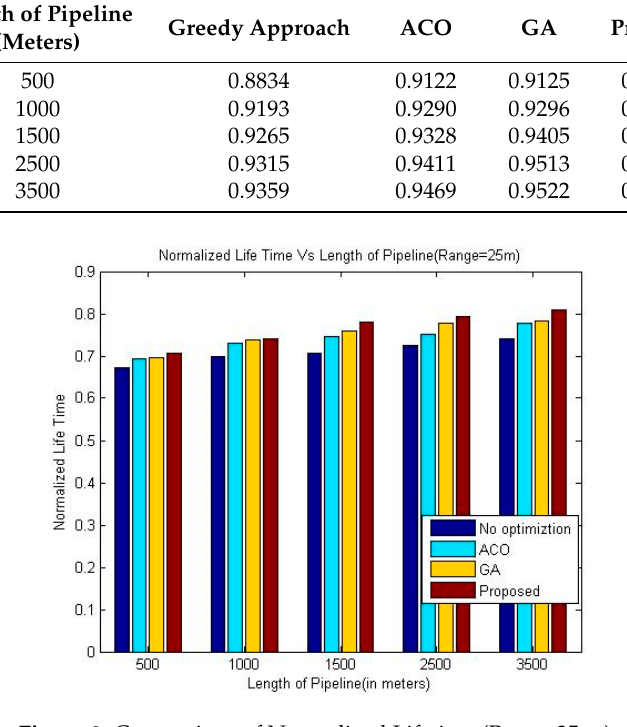
Figure 9. Comparison of Normalized Lifetime (Range 25 m). Sensors 2018 , 18 , x FOR PEER REVIEW